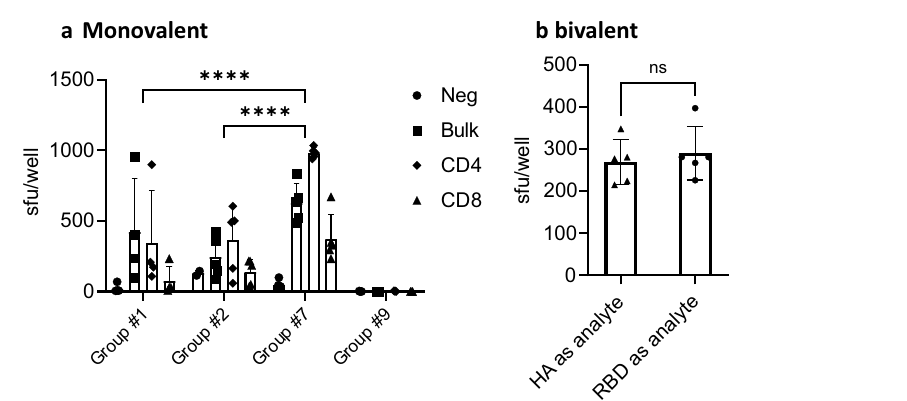
Figure 8. Bivalent SARS-CoV-2 RBD-cCPE/influenza H1-HA 1 -cCPE induces SARS-CoV-2 pseudovirus (Delta variant B.1.617.2) neutralizing antibodies in NALF, BALF and serum. Mice (n = 5) were prime-boost immunized intranasally (days 0 and 21) with bivalent SARS-CoV-2 RBD-cCPE/Influenza H1-HA 1 -cCPE vaccine, adjuvanted with Riboxxim. NALF, BALF and sera were obtained on day 28, 1 week after the boost, diluted in tenfold steps, and assayed for neutralization of SARS-CoV-2 pseudoviruses. The spike protein sequence was derived from SARS-CoV-2 strain B.1.617.2.